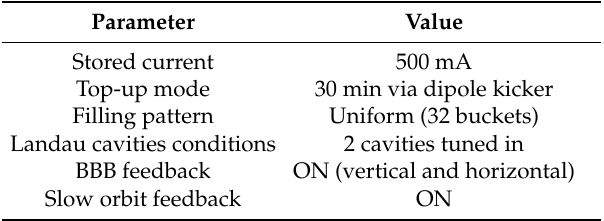
Table 2. Nominal operations conditions for the 1.5 GeV storage ring.